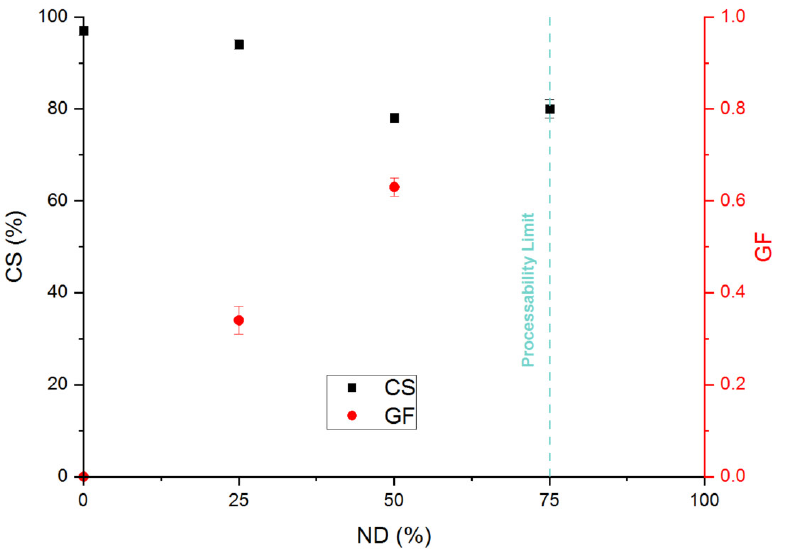
Figure 5. Variation of the compression set ( ■ ) and the gel fraction (●) for the EPDM-g-MA cross- linked with different KOH concentration (ND). No DCP has been added in these formulations.